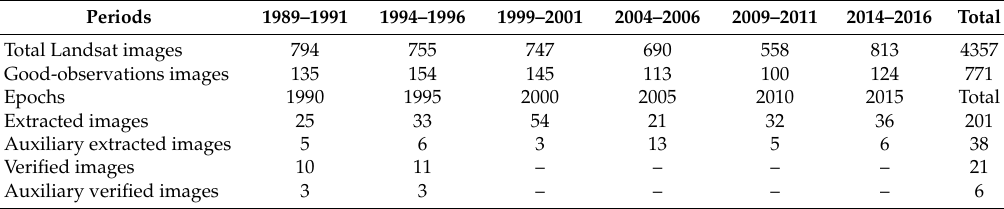
Figure 2. Flow chart for developing an updated method of determining cropland patterns. The new time series cropping pattern dataset in five-year increments from 1990 to 2015 based on the NLCD dataset and multiple Landsat images, and the predicted future patterns for the period of 2020–2050. Table 1. Statistical information regarding the Landsat images for time series cropping pattern extraction.